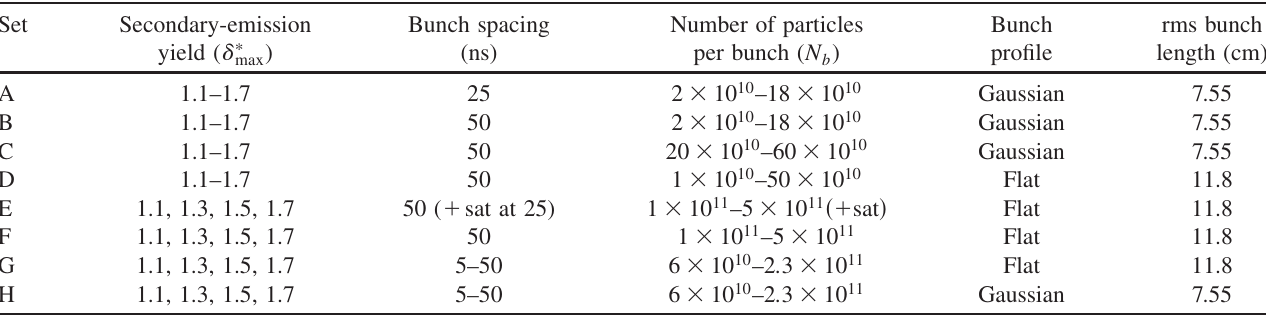
TABLE III. Summary of simulation